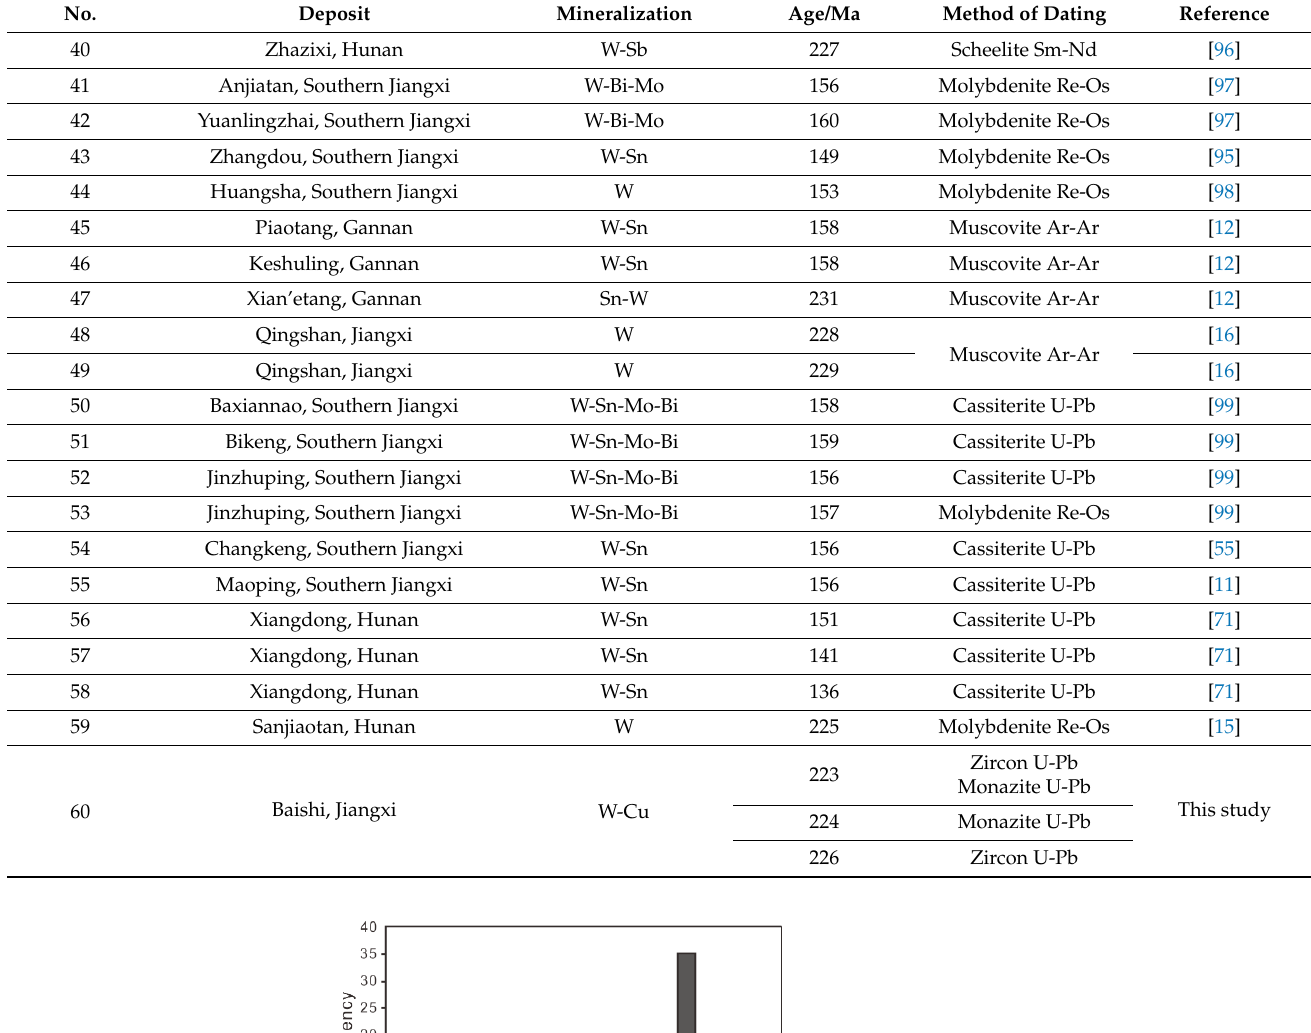
Figure 9. The metallogenic age of the tungsten polymetallic deposits in the Nanling region (detailed reference in Table 4).